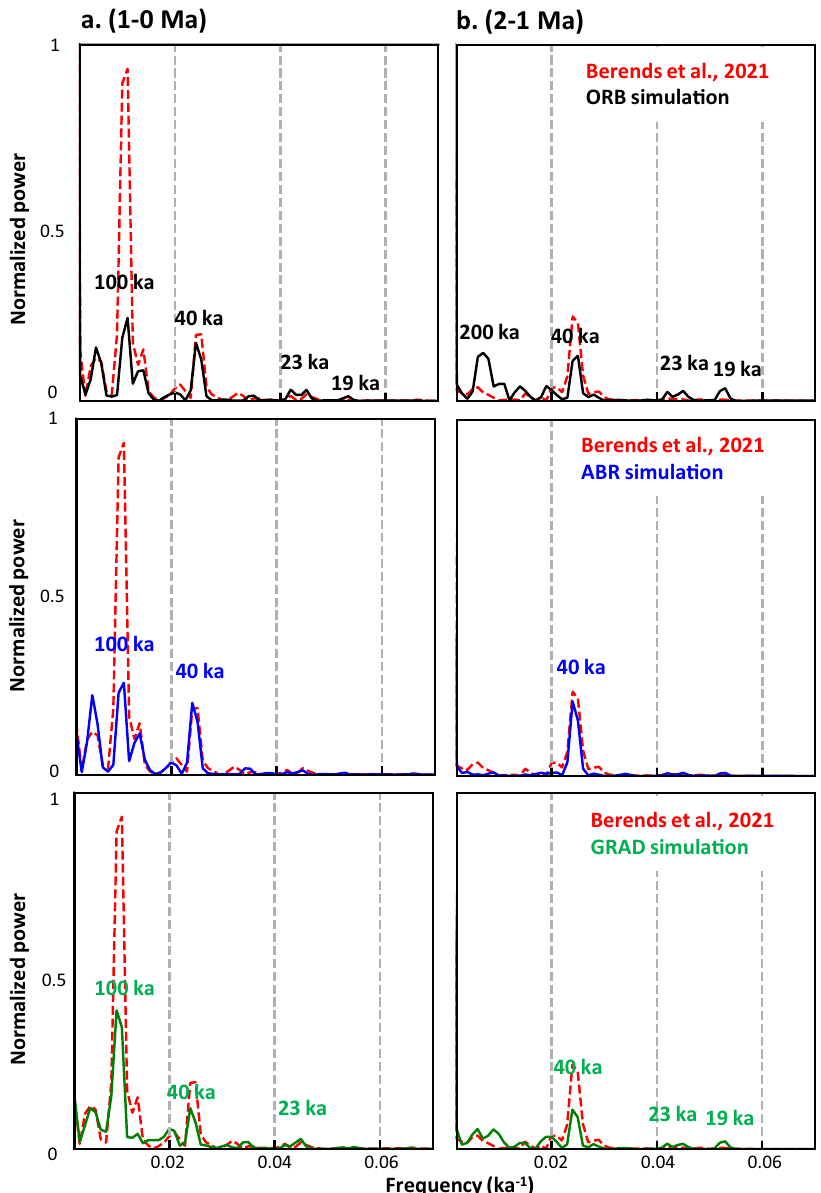
Fig. 4 Spectral analyses on the simulated and reconstructed global ice volume changes. Spectral analyses for the 1-0 Ma ( a ) and 2-1 Ma ( b ) time intervals for the ORB (dark), ABR (blue), and GRAD (green) simulations and the global ice volume reconstruction of ref. 41 (red).